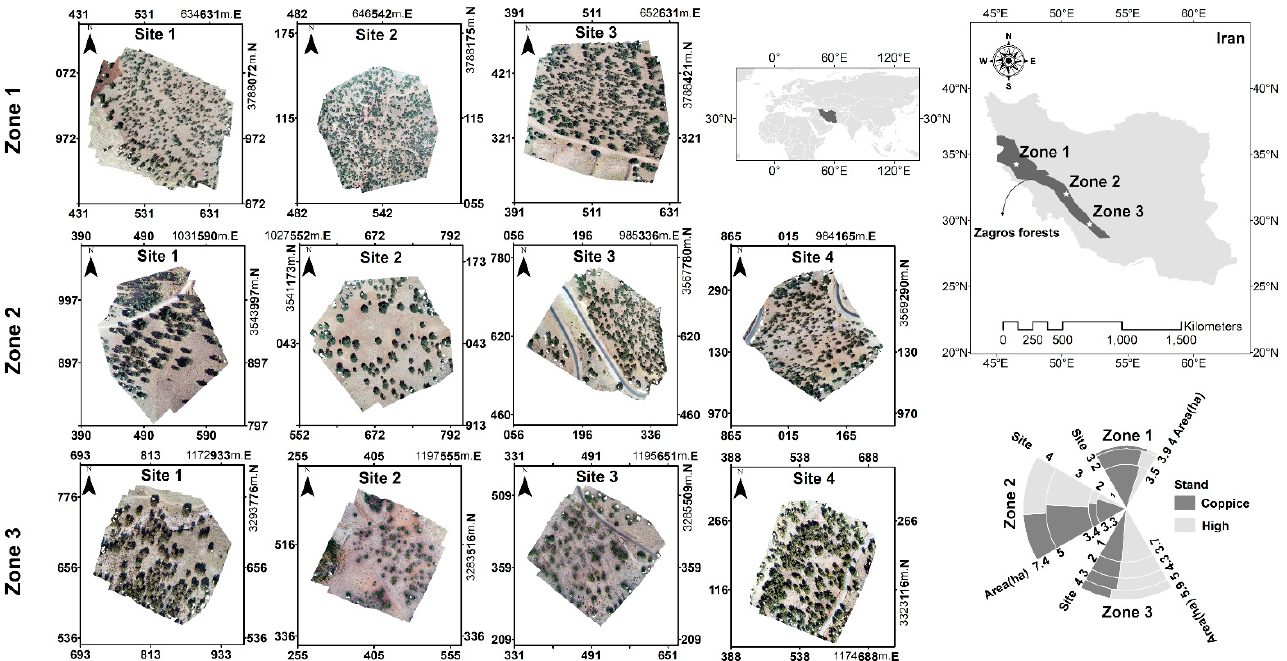
Figure 1. The study area includes 11 sites from the three northern (Zone 1), middle (Zone 2), and southern (Zone 3) regions of the Zagros Forests. Each site is represented by UAV orthophotos. The locations are in the UTM zone 38N coordinate system. According to the pie-chart, all sites comprise both high and coppice trees, while in Zone 1, the predominant form is coppice.